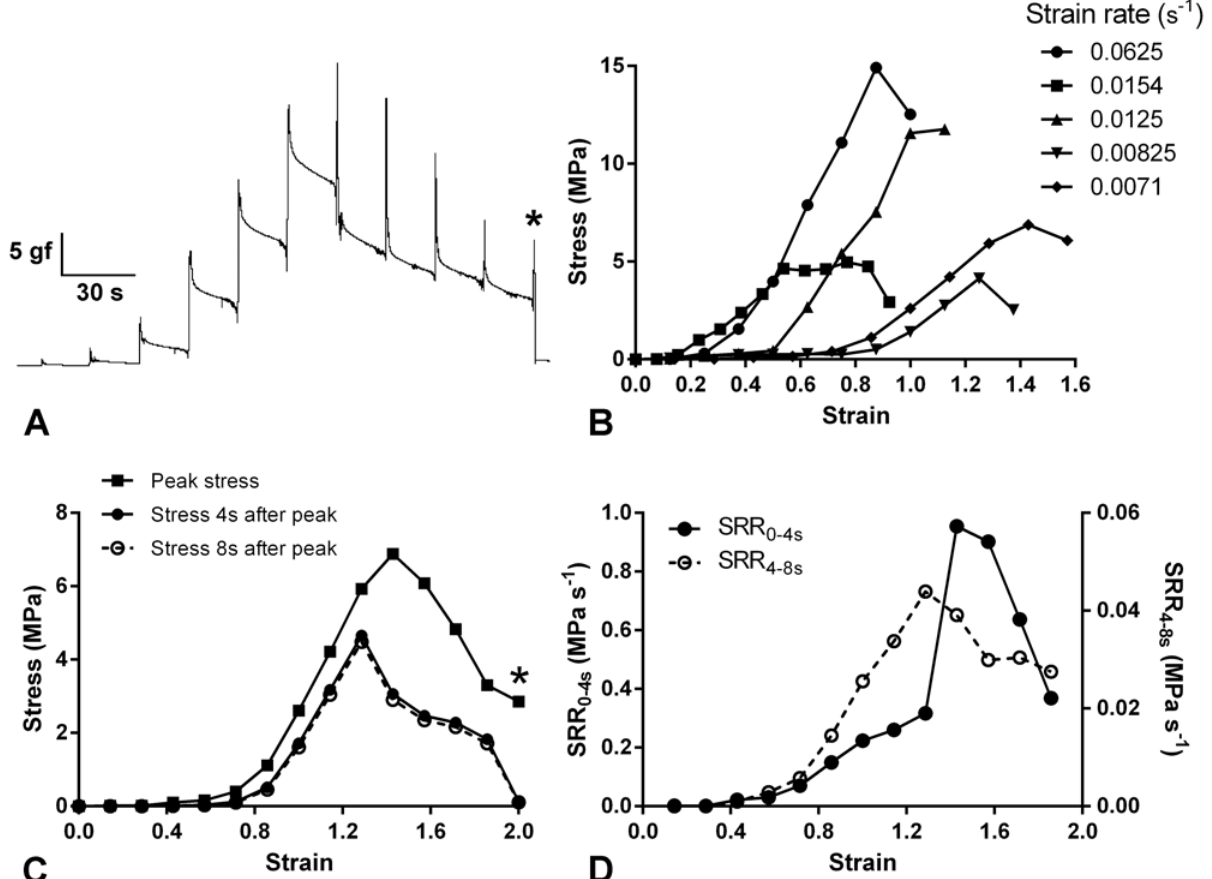
Fig 4. Force-extension and stress relaxation behaviour of P . lividus CDs. (A) Recording of a representative force-extension test in which the CD was extended by 0.5 mm every 20 s. At each extension the force reached a peak then decayed in two phases (rapid and slow). The asterisk indicates the point at which rupture occurred. (B) Complete set of stress-strain curves derived from force-extension tests on five CDs from one animal. This set of curves is representative in terms of the apparent non-strain rate dependence of the duration of the toe region, the tensile strength and the breaking strain. For the sake of clarity, most of the curves are curtailed before the rupture point. (C) Stress-strain curves of one CD derived from the recording shown in Fig. 4A and which is one of the batch featured in Fig. 4B (strain rate 0.0071 s -1 ). Comparison of the curves for peak stress, stress 4 s after the peak was reached and stress 8 s after the peak was reached. Considerably more stress relaxation occurred in the 4 s after peak stress than in the subsequent 4 s. The asterisk indicates the point at which rupture occurred. (D) Stress relaxation data from Fig. 4C expressed as mean stress relaxation rates (SRR) during the periods 0 – 4 s and 4 – 8 s after each peak stress was